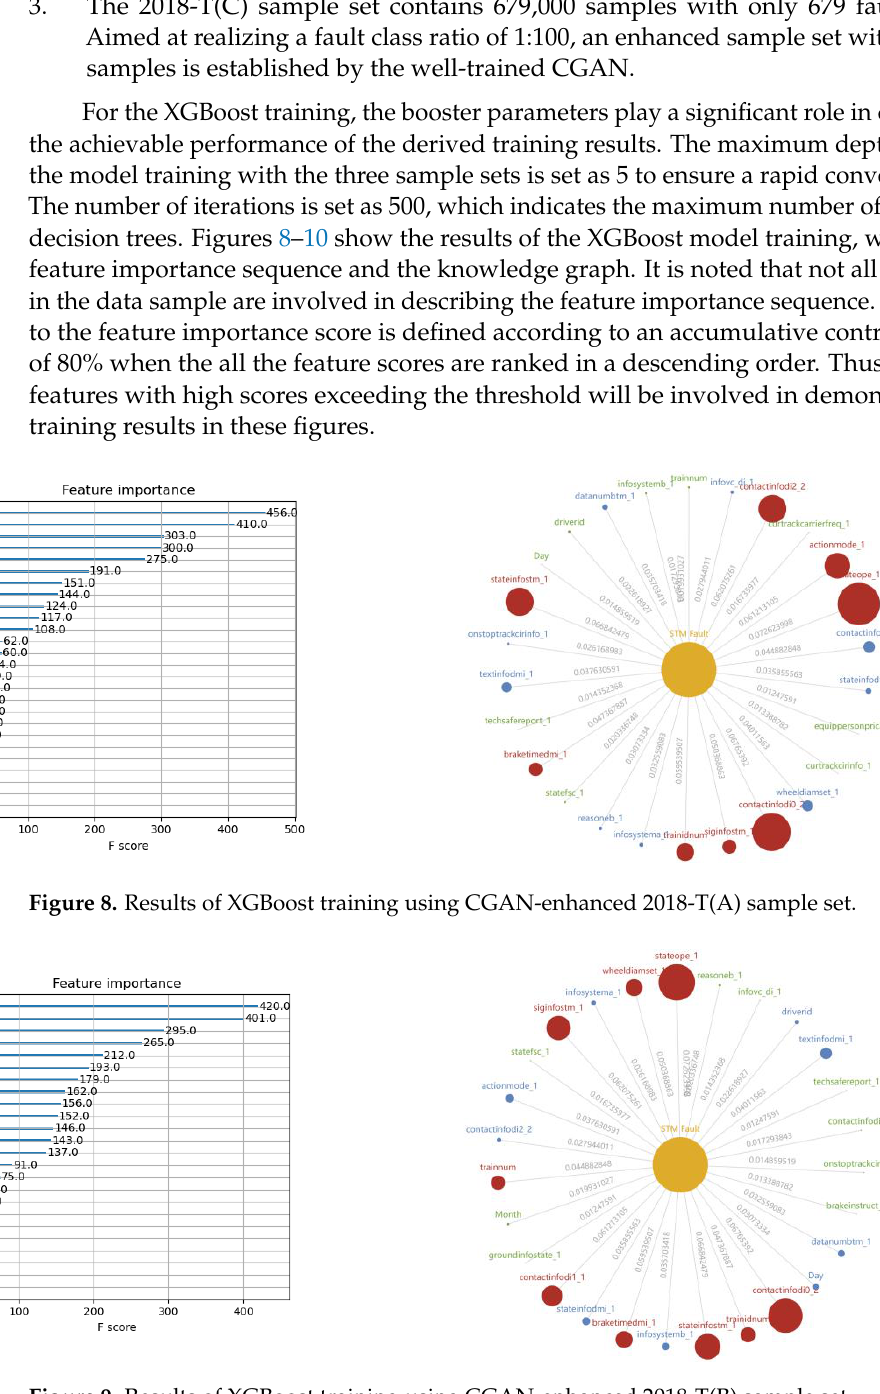
Figure 10. Results of XGBoost training using CGAN-enhanced 2018-T(C) sample set. The obtained XGBoost model consists of many decision trees, and a new tree will be added into the model in each iteration cycle. With the increasing sub-models along with the training process, the complexity of the ensemble model will grow gradually. When the training is finished, an ensemble of trees can be derived, with which prediction can be performed for the equipment health assessment and other related PdM operations. Fig- ures 11 – 13 show the typical sub-models in the training with the three training samples.